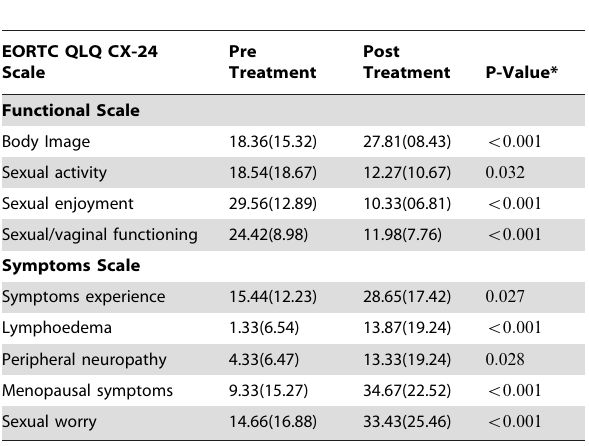
Table 2. Comparative pre and post treatment EORTC QLQ C- 30 Quality of Life scores in cervical cancer women.